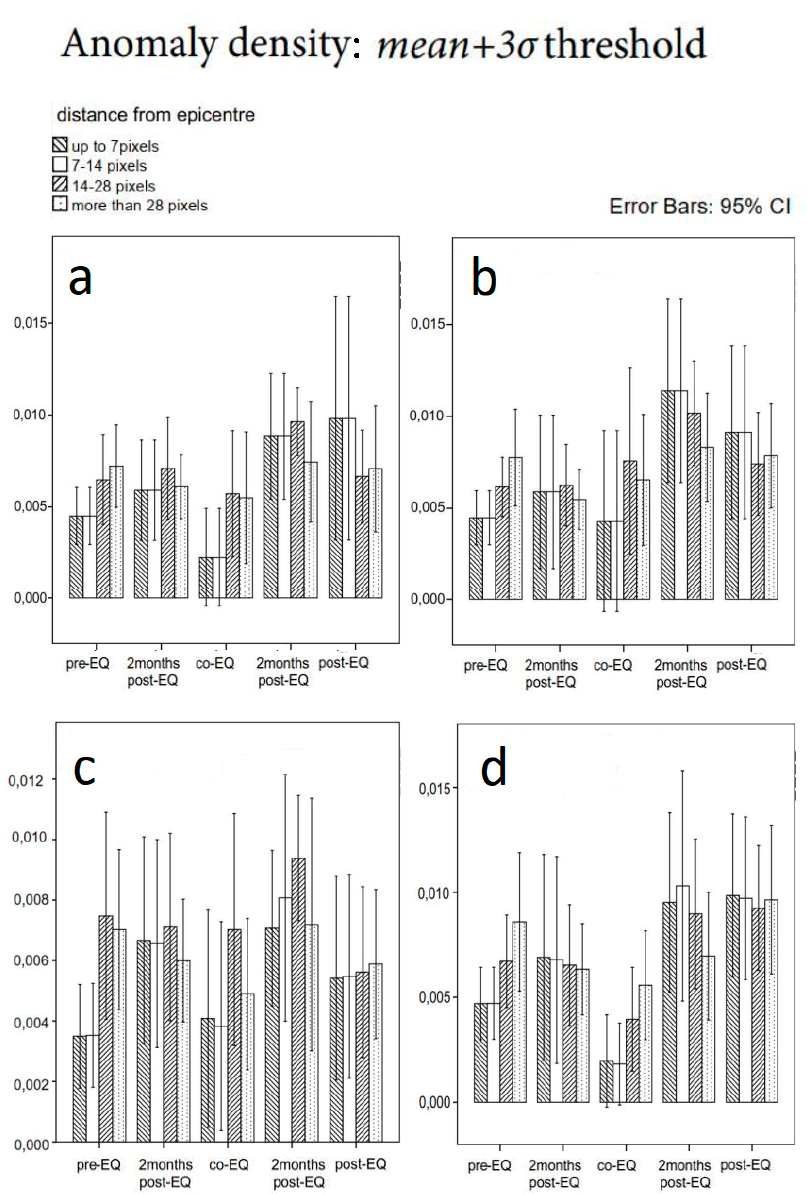
Figure A2. Anomaly density using a µ + 3 σ threshold and adjusted co-seismic period. Results from all earthquake cases grouped per time period, spatial zone and earthquake year. ( a ) Earthquake years, 48-h co-seismic period ( b ) No-Earthquake years, 48-h co-seismic period ( c ) Earthquake years, adjusted co-seismic period ( d ) No-Earthquake years, adjusted co-seismic period.